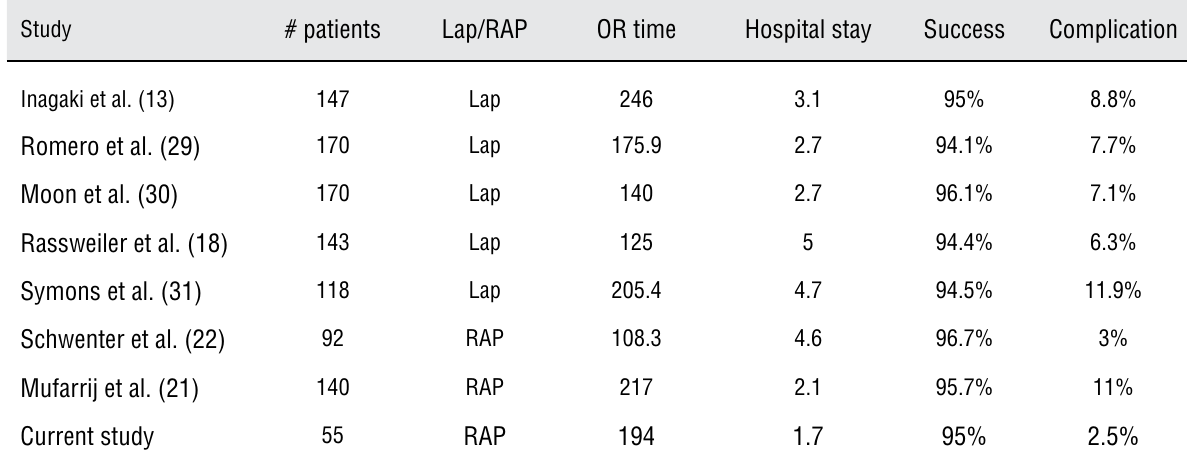
Table 4 - Laparoscopic/Robotic series.